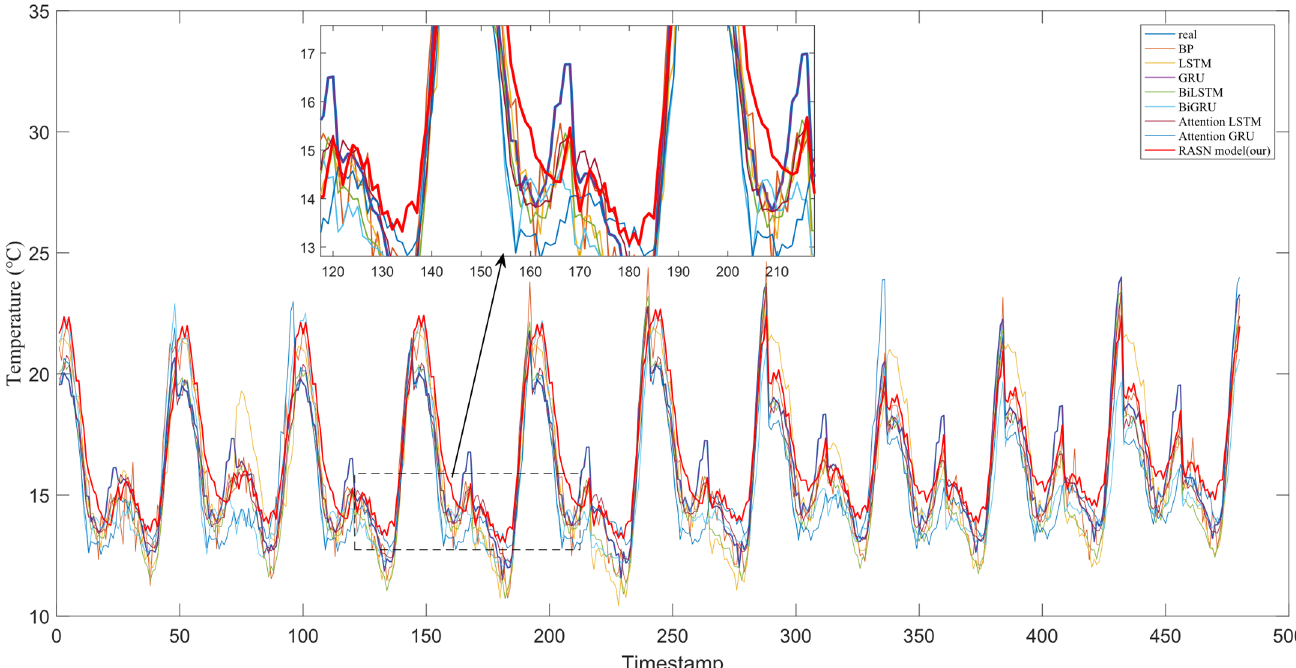
Figure 7. Comparison of model predictions based on temperature data.